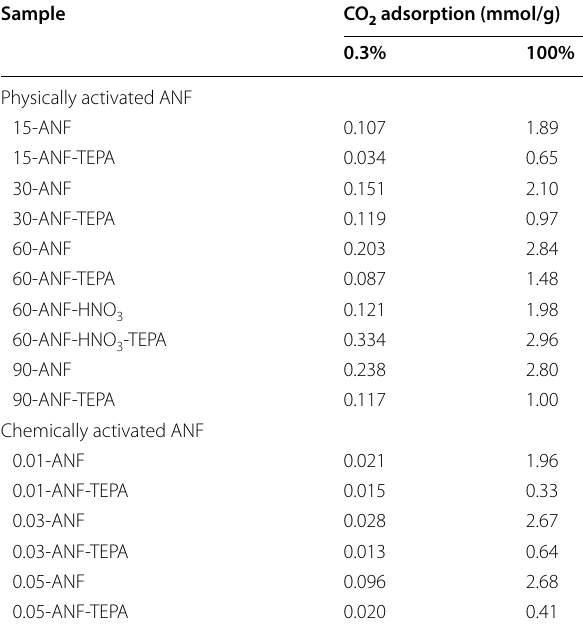
Table 5 CO adsorption capacities (q) of all ANF 2